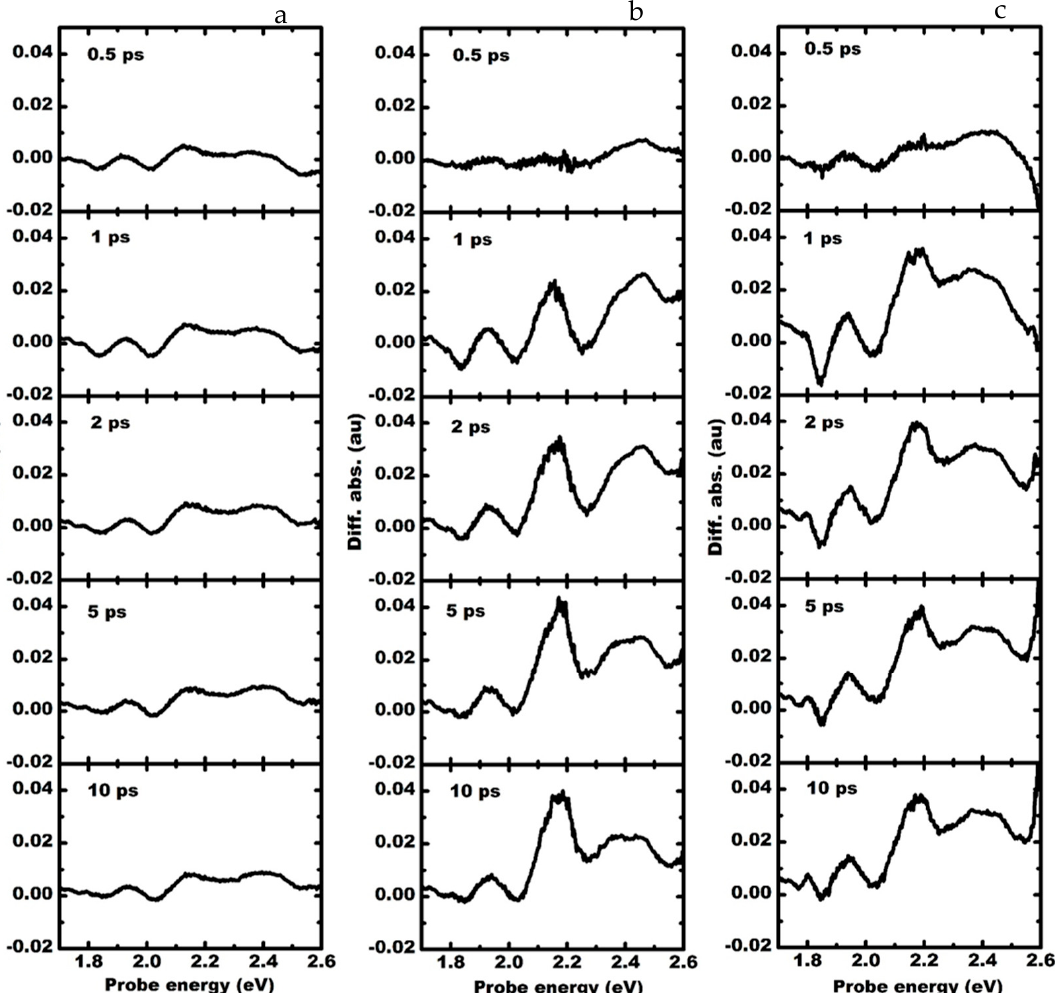
Figure 5. The transient absorption spectrum of ( a ) MoS 2 -GaN (left column), ( b ) MoS 2 -GaN with Au plasmons (middle column), and ( c ) MoS 2 -GaN with Pt plasmons (right column) with 3.54 eV pump at different delay times showing the dynamics of A and B excitonic absorption state in MoS 2 , photoinduced absorption band and the defect band of GaN.